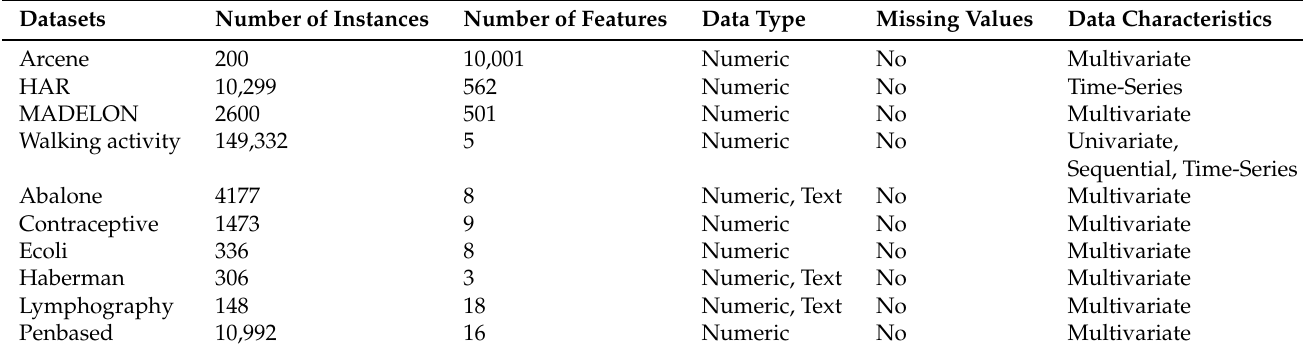
Table 2. Datasets